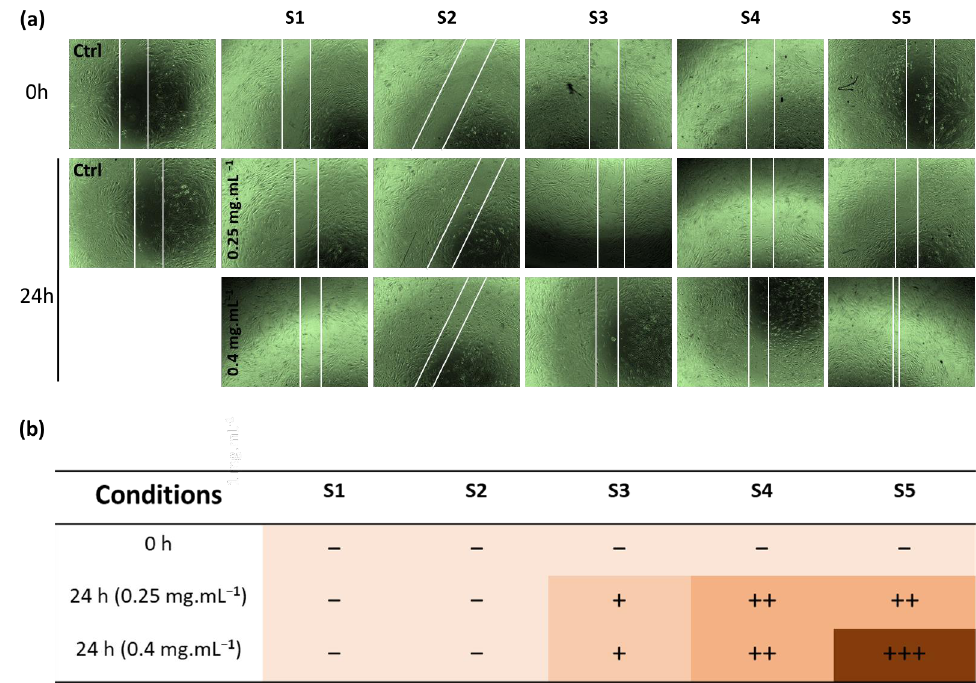
Figure 7. Cell scratch assay on human fibroblasts treated (or not) with different concentrations of pure extract and MOE/SA/PVA and observed at 0 to 24 h after treatment ( a ). Representative table of the wound - scratch - healing capacity of the different scaffolds when compared with the control ( b ).